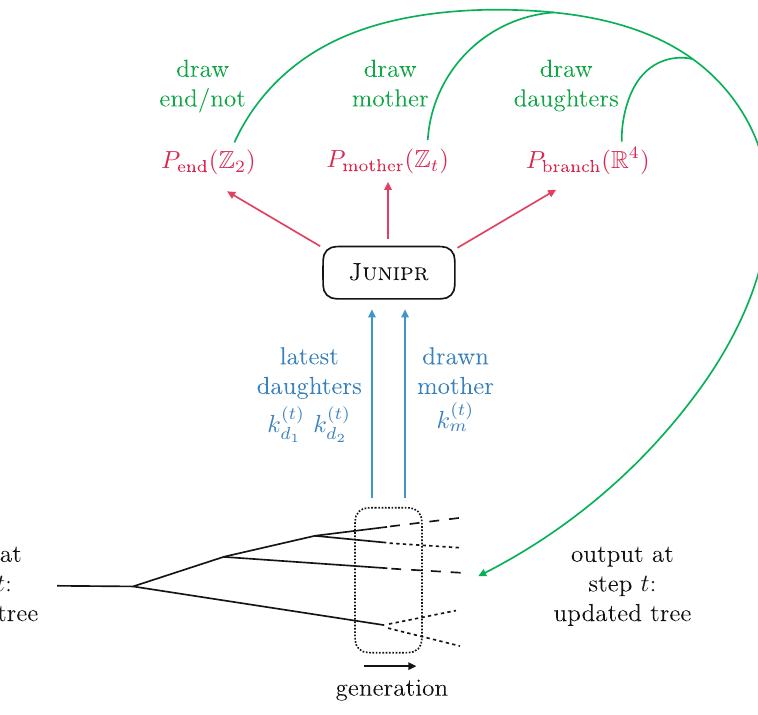
Fig. 14 Sampling from Junipr to generate jets. Draws from low-dimensional distributions at each step t are fed forward to subsequent steps to ultimately generate a full